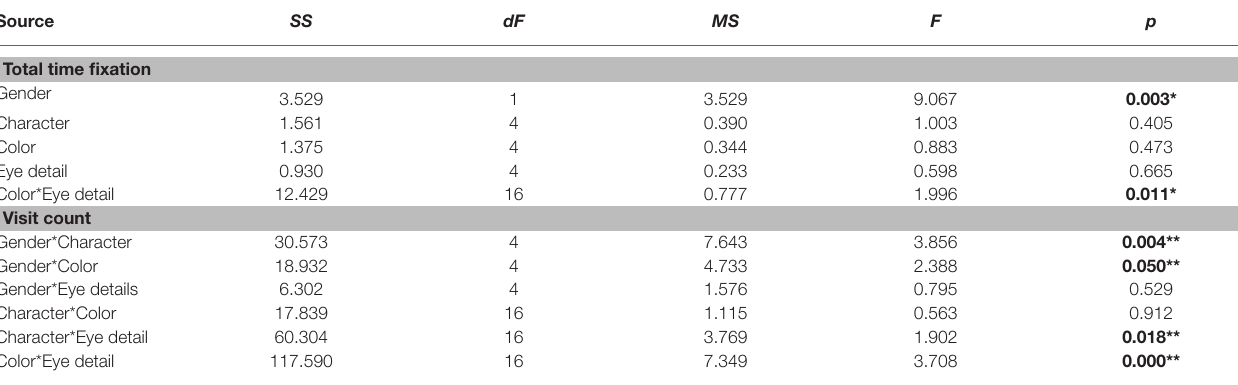
TABLE 1 | Statistical result of multivariable ANOVA (MANOVA) for independent variables for icons. Source SS dF MS